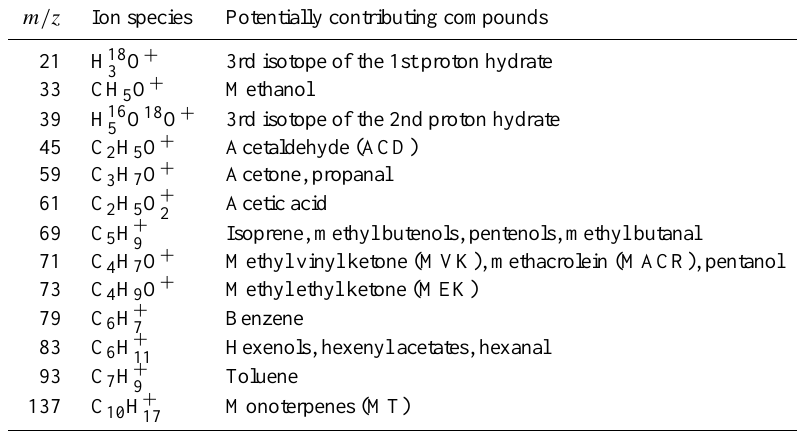
Table 1. m/z ratio of ion species measured at LTO and their potentially contributing compounds.